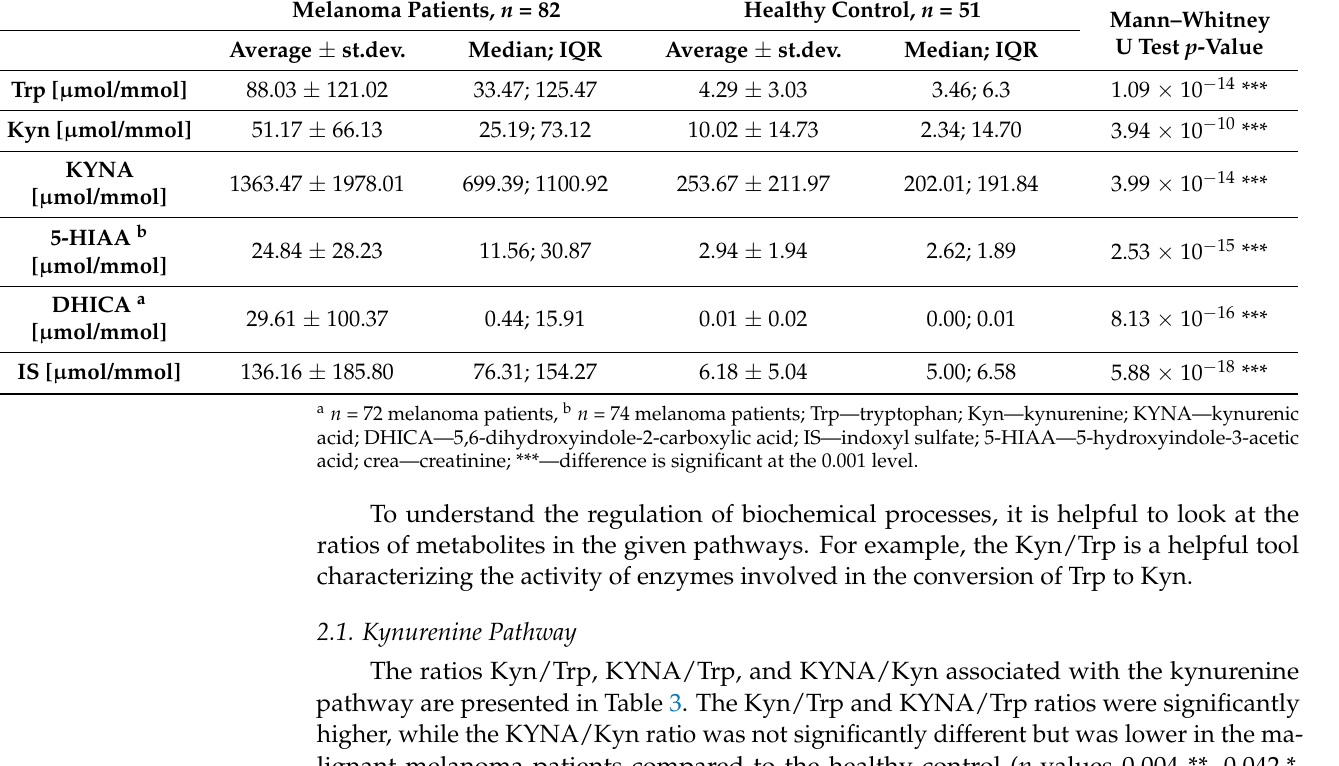
U Test p -ValueAverage ± st.dev.